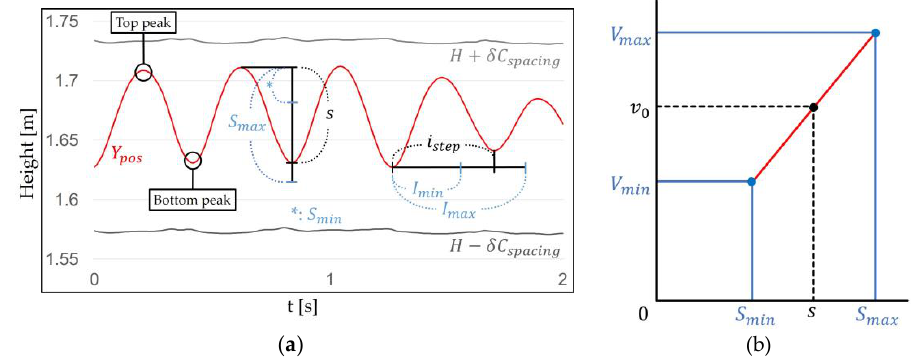
Figure 8. ( a ) Using the top and bottom peaks in the WIP pattern, s and 𝑖 𝑠𝑡𝑒𝑝 can be obtained. S and I thresholds are determined when the target user performs intentional motion. ( b ) Equation (3) uses linear interpolation to determine 𝑣 0 .